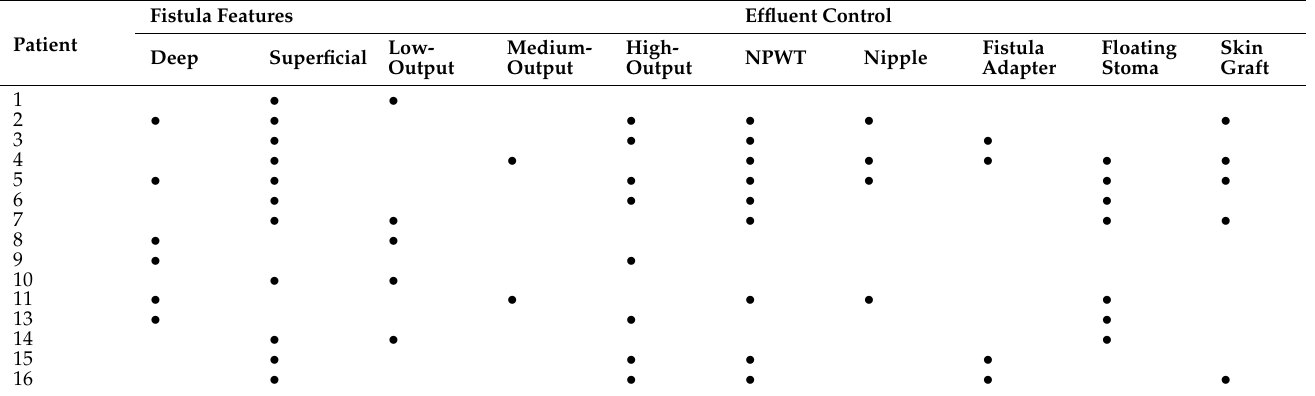
Table 3. Fistula features and techniques for output control.